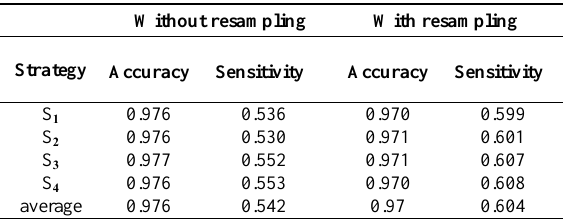
Table 8. Results of proposed methodology (without cost sensitive